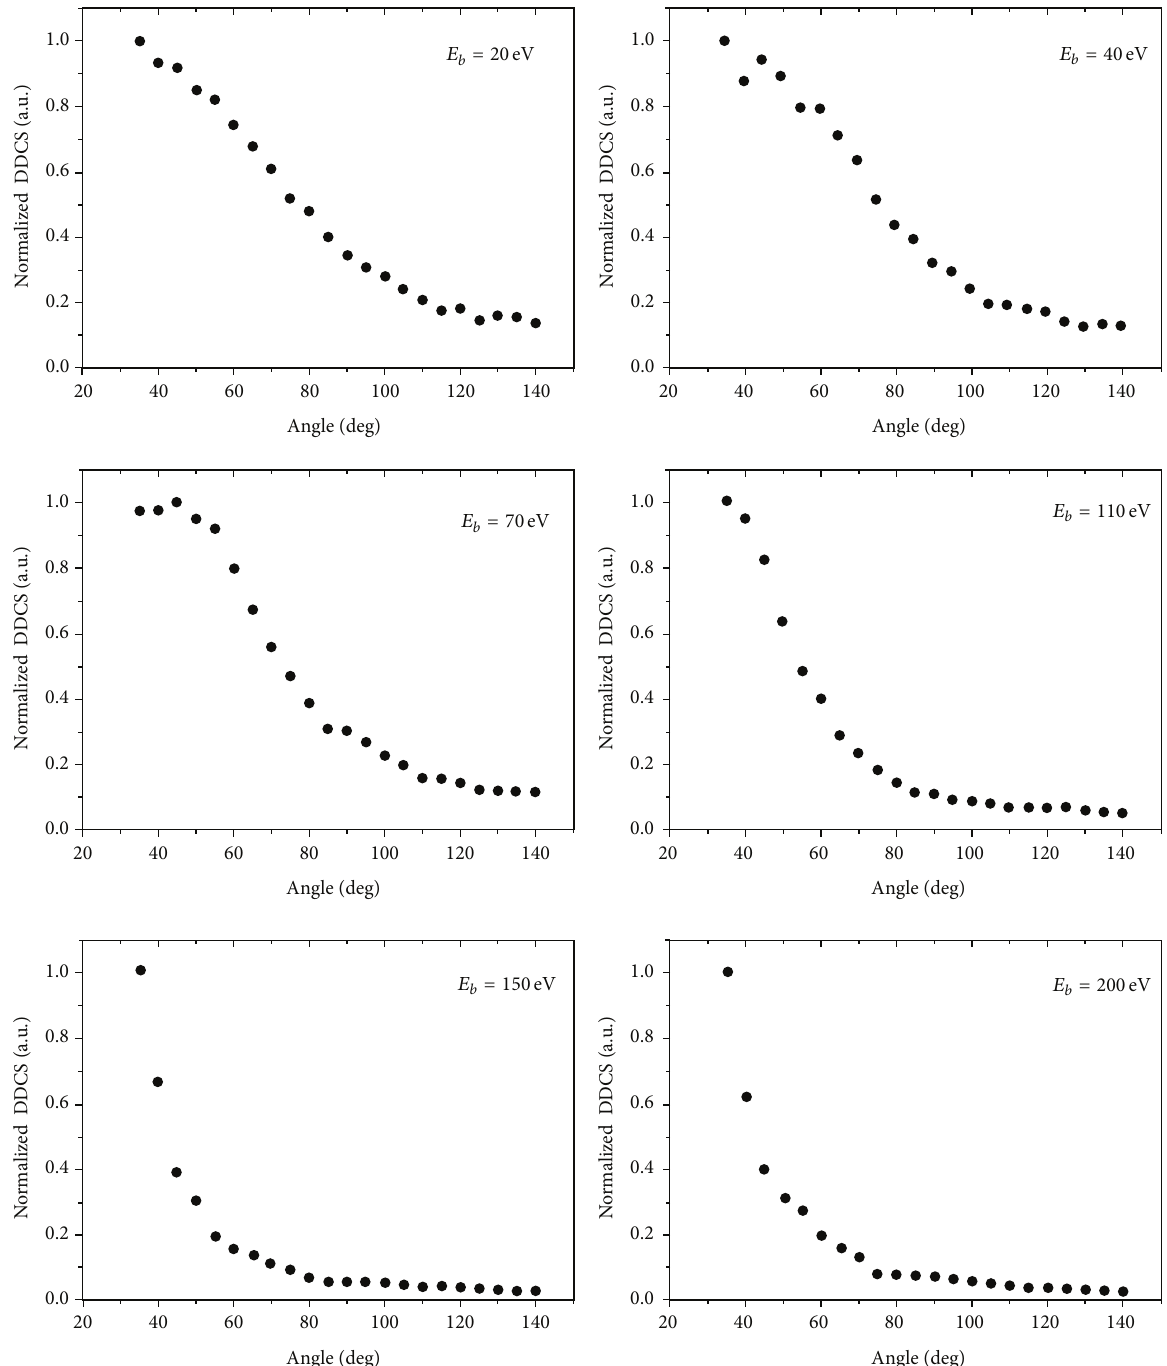
Figure 13: Present measurements of DDCS for He at 250 eV electron impact energy for outgoing electron energies between 20–200 eV.